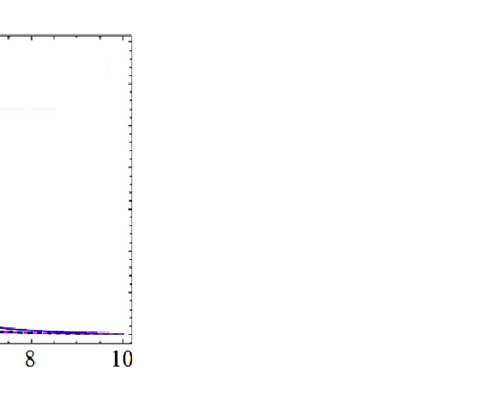
Fig 11. Thermal characteristics for different values of Prandtl number.